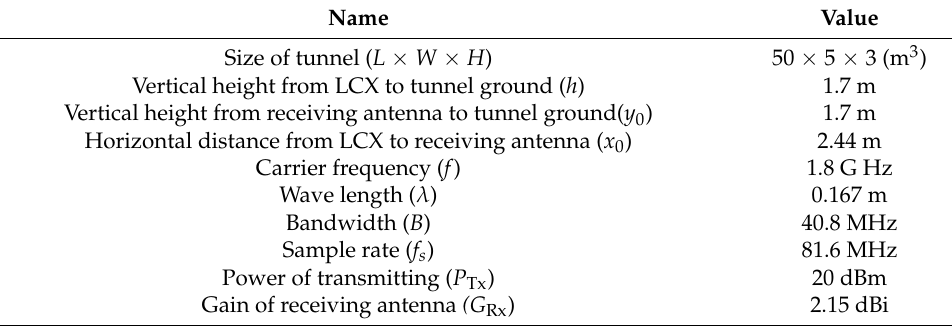
Table 3. Parameters setup of measurement